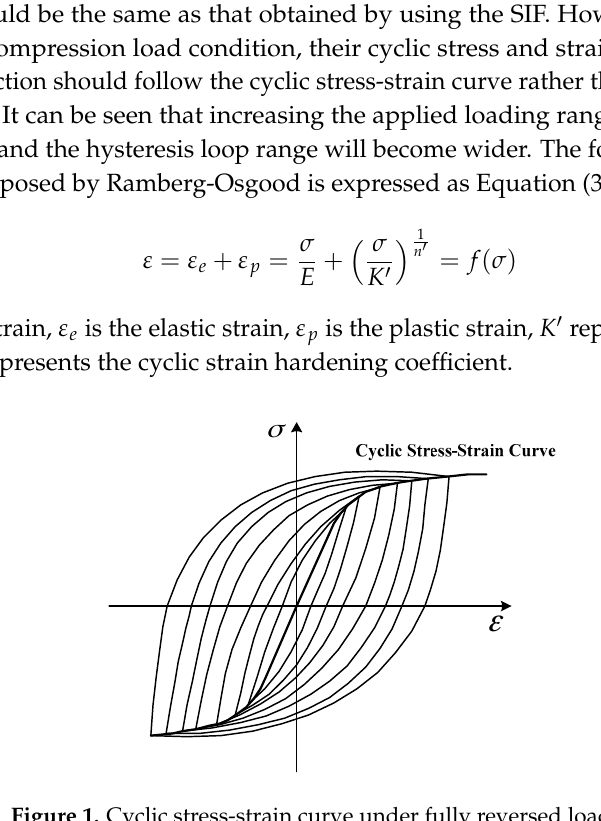
Figure 1. Cyclic stress-strain curve under fully reversed loading.